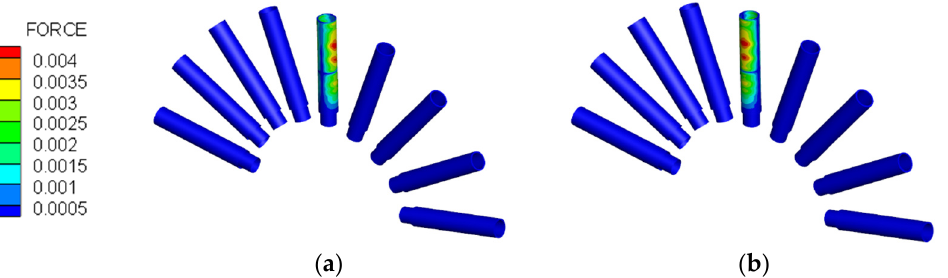
Figure 8. Aerodynamic influence coefficient distribution: (a) First mode; (b) Second mode.